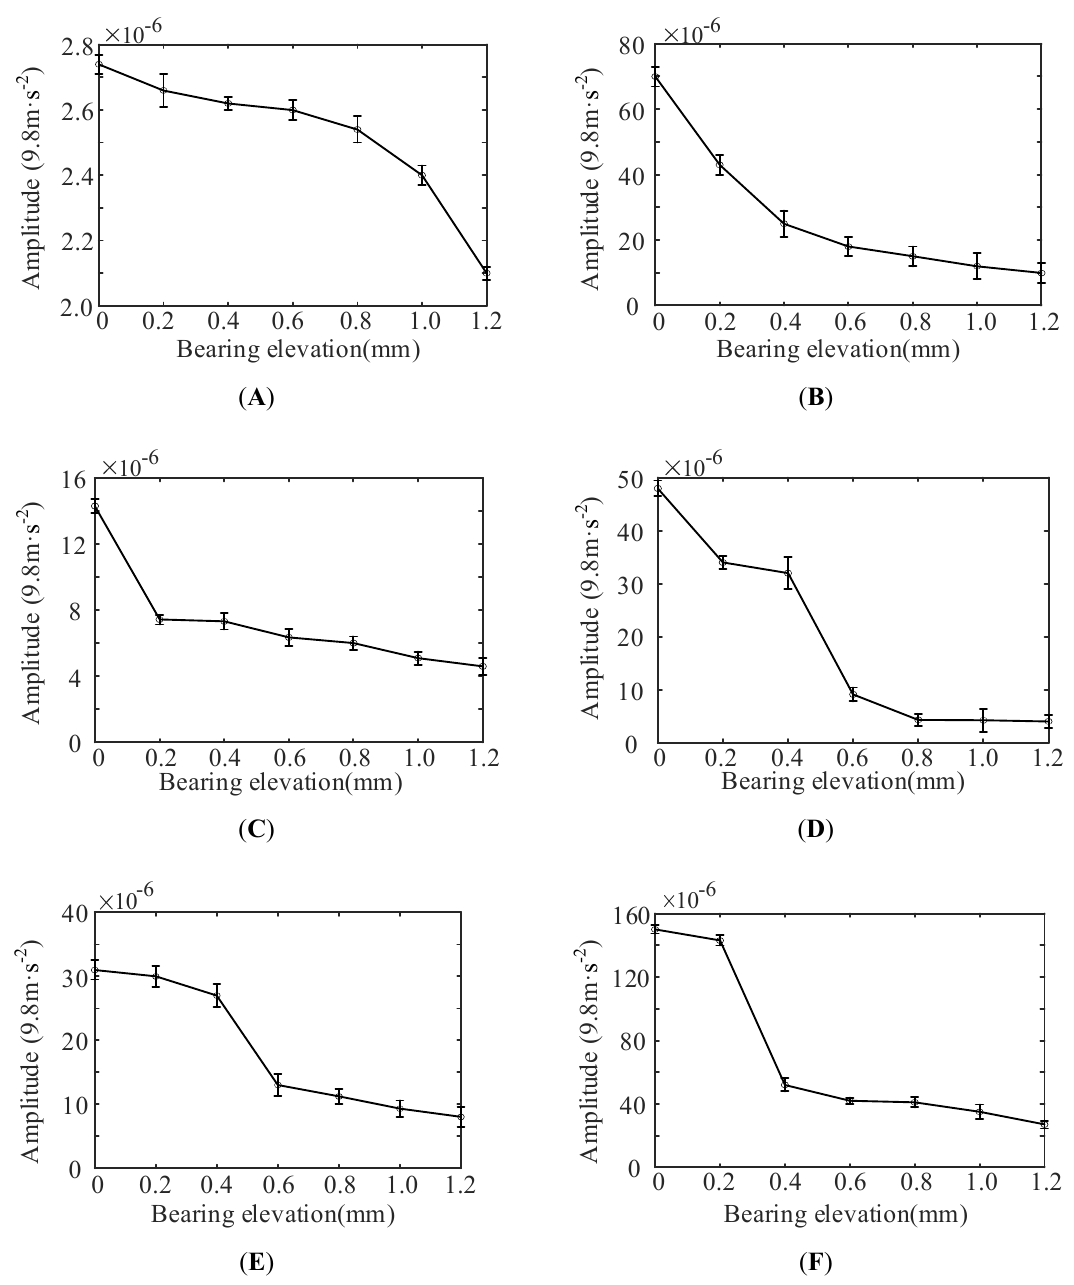
Figure 13. The amplitude change trend of the first six-order natural frequency: ( A ) First-order natural frequency; ( B ) Second-order natural frequency; ( C ) Third-order natural frequency; ( D ) Fourth-order natural frequency; ( E ) Fifth-order natural frequency; ( F ) Sixth-order natural frequency.